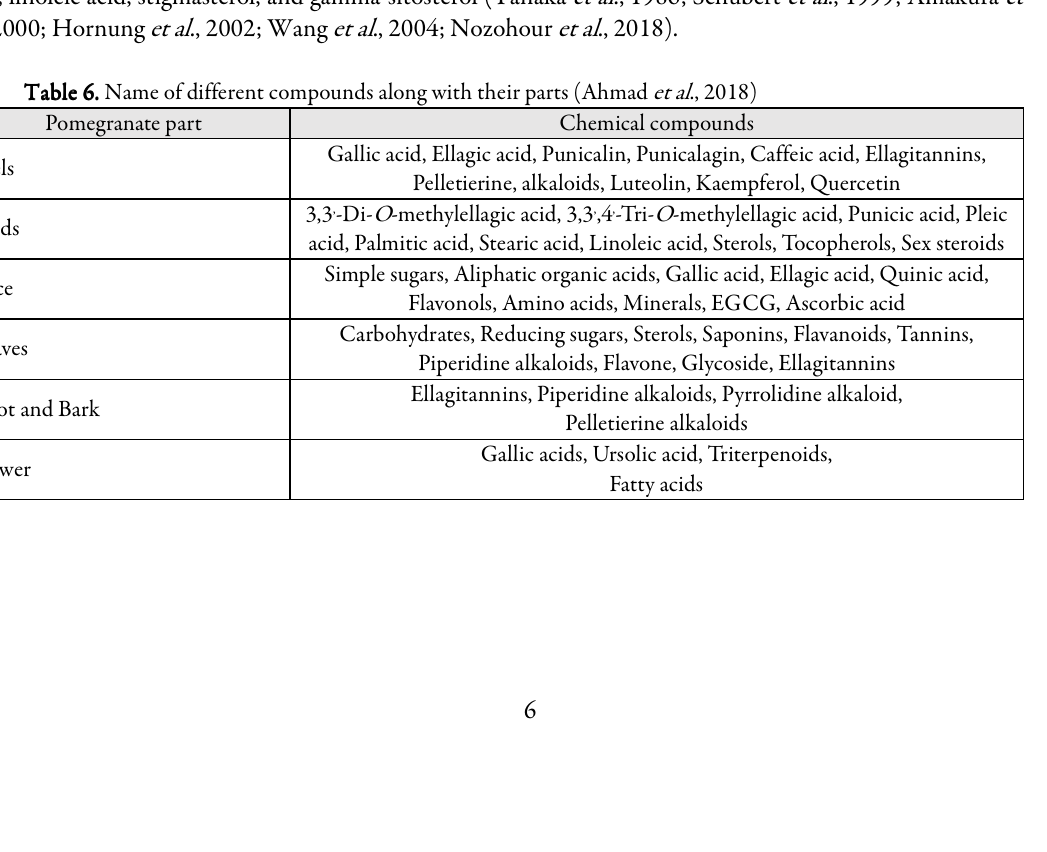
Table 6. Name of different compounds along with their parts (Ahmad et al ., 2018) Pomegranate part Chemical compounds